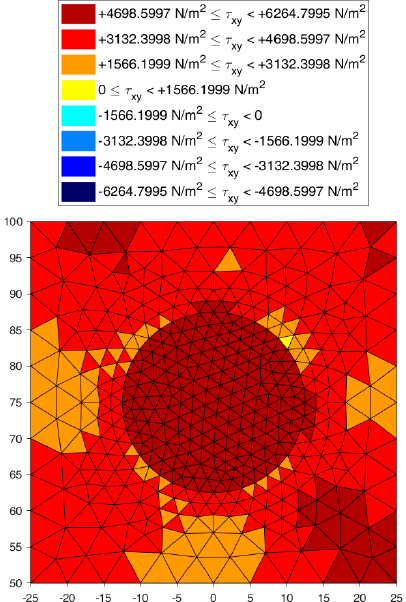
Figure 25. Detail of the shear stress τ xy for the discrete element i = 2, j = 2 (colors equally ranged